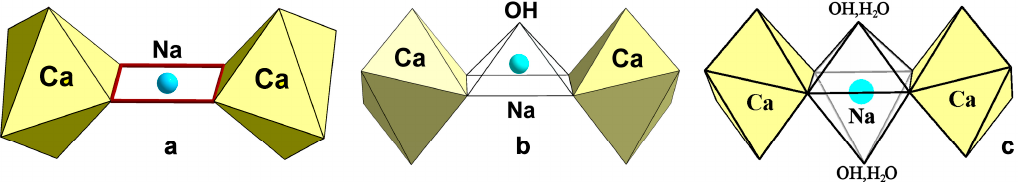
Figure 5. Na-centered coordination polyhedra in the structures of eudialyte-group minerals: square ( a ), tetragonal pyramid ( b ) and octahedron ( c ).